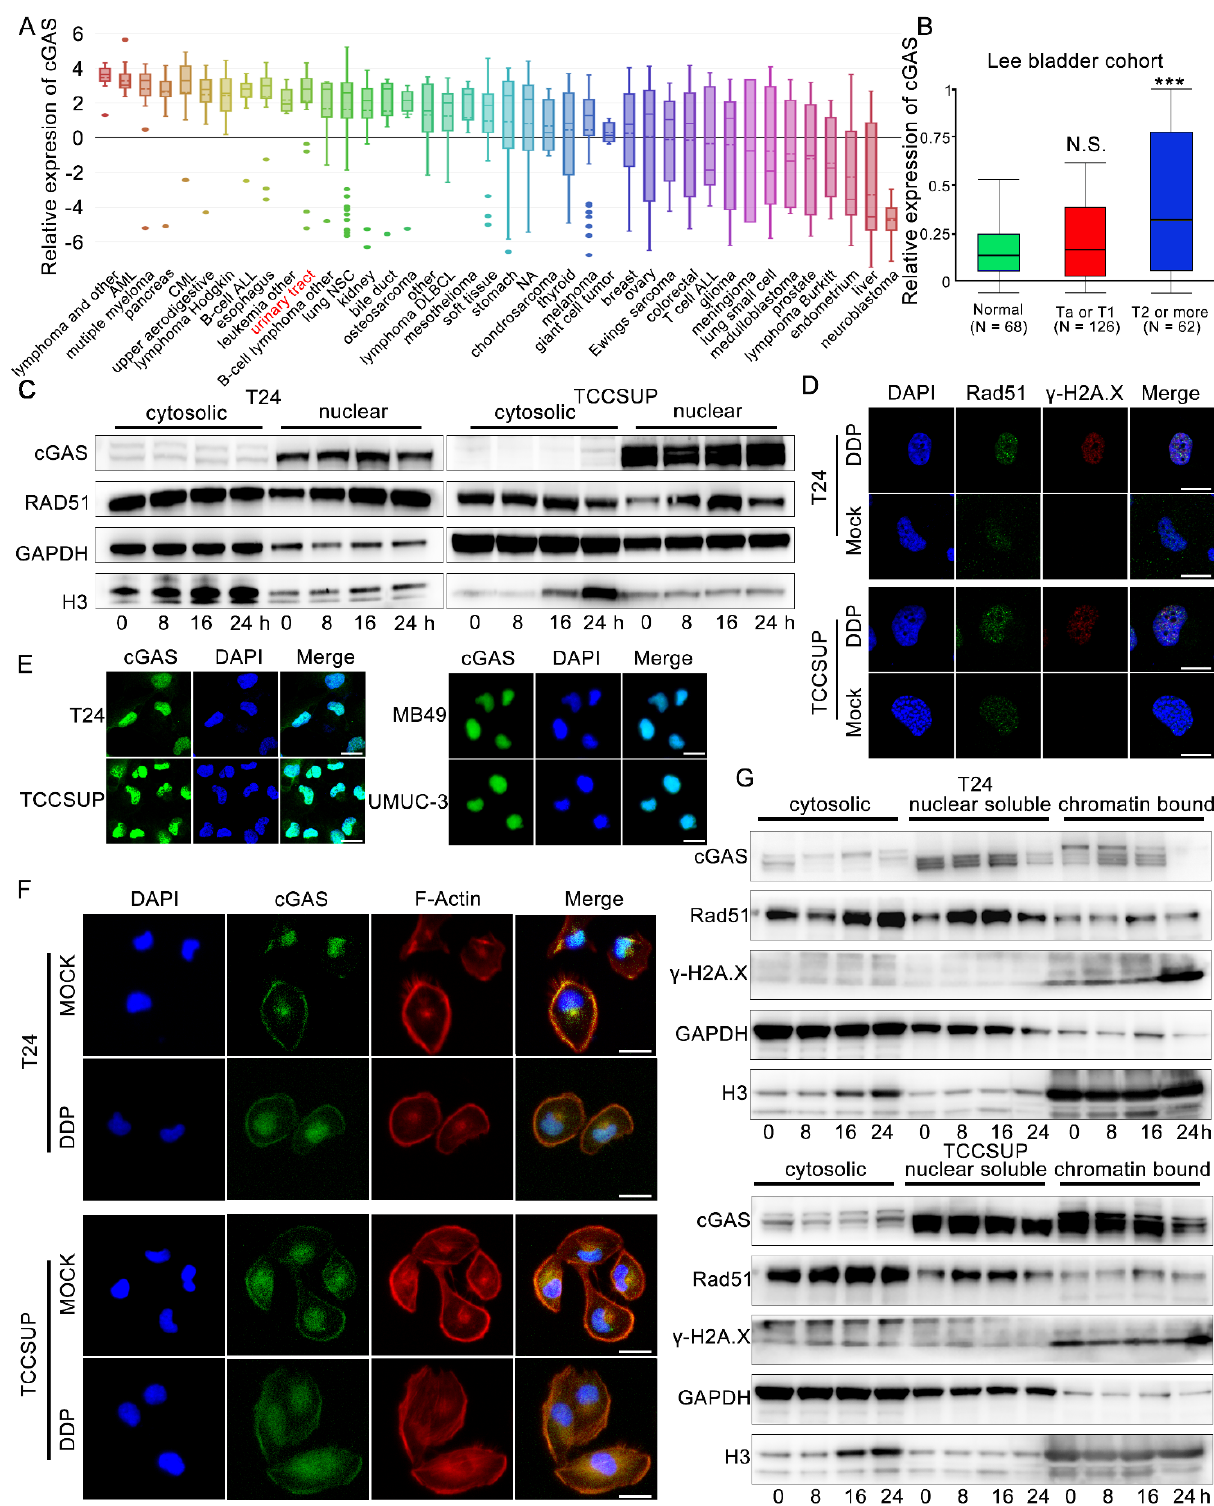
Figure 5. Cisplatin induced dsDNA and the releasing of chromatin bound cGAS may function as an important role in enhancing STING signal. ( A ) Basic transcription levels of cGAS in bladder cancer cell line on CCLE database. ( B ) Relative transcriptional expression of cGAS in different T stages (Normal N = 68, Ta or T1 N = 126, and T2 or more N = 62) in Lee bladder cohort. ( C ) Western blotting of subcellular distribution of cGAS, Rad51 GAPDH, and Histone H3 proteins. GAPDH was used as cytosolic control protein, and histone H3 was used as nuclear control proteins. T24 and TCCSUP c ell treated with 2 μg /mL cisplatin or PBS at 0 h, 8 h, 16 h, 24 h time points. ( D ) Immunofluorescence of expression and distribution of Rad51 and γ -H2A.X proteins in T24 and TCCSUP cell lines treated